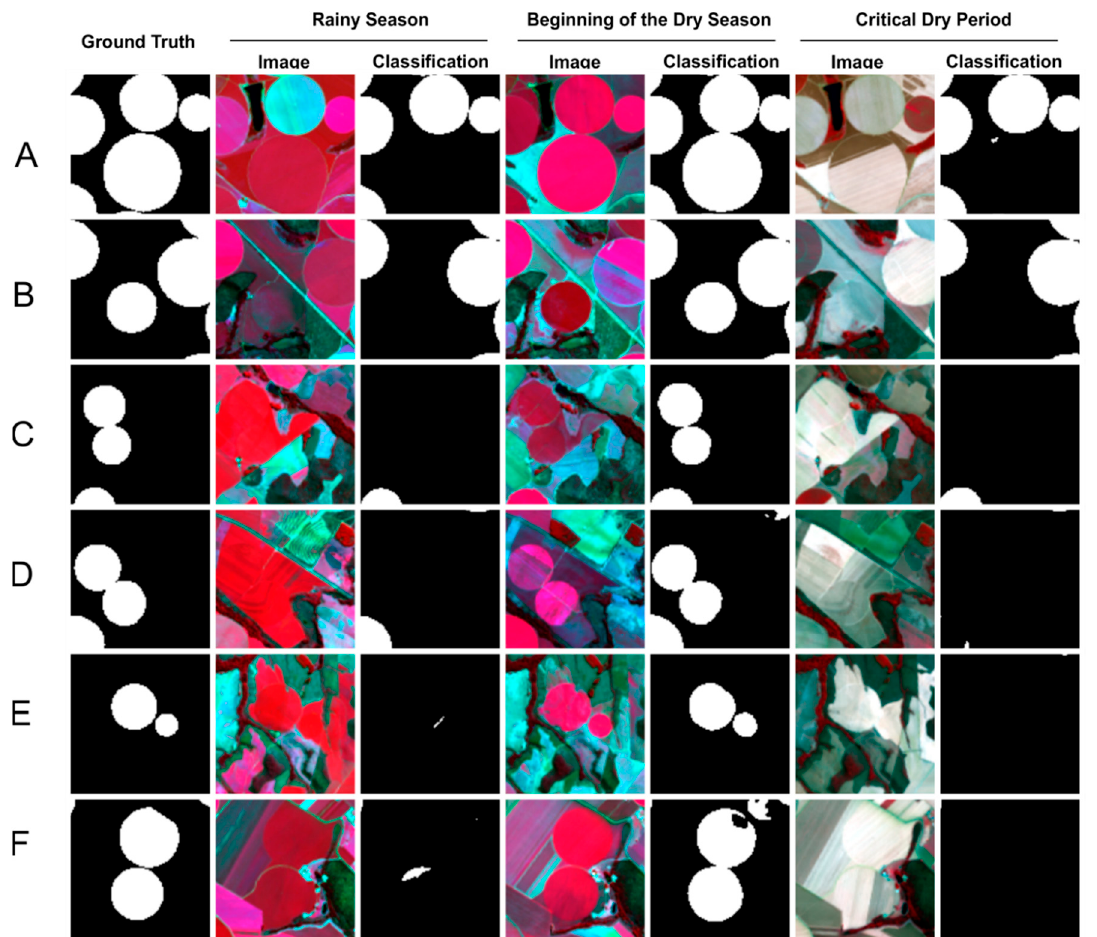
Figure 11. Comparison of zoomed areas ( A – F ) at di ff erent times of the year (rainy season, early dry, and critical dry seasons). The examples demonstrate that only images from the beginning of the dry season detect the center pivots.